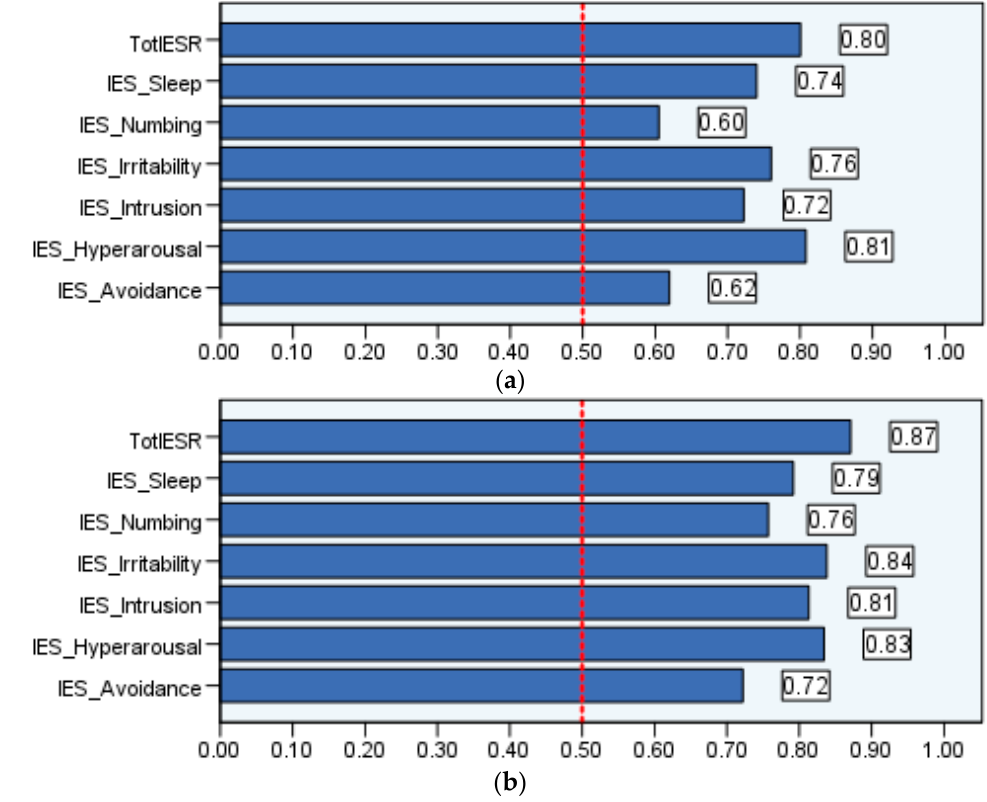
Figure 2. Model quality of the receiver operating characteristic (ROC) curve analyses which used the Arabic version of the Impact of Event Scale-Revised (IES-R) and its subscales to predict psychological distress among people with mental disorders ( a ) and healthy adults ( b ). Table 2. Cutoff scores of the Arabic version of the Impact of Event Scale-Revised (IES-R) and its subscales, along with goodness-of-fit indices associated with receiver-operating characteristic (ROC) curve analysis in patients with mental disorders (sample 1) and healthy adults (sample